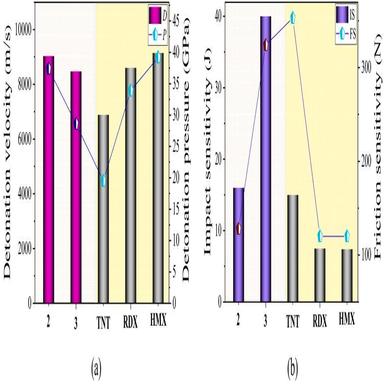
Comparison between (a) detonation properties and (b) mechanical performance of 2, 3, TNT, RDX and HMX.